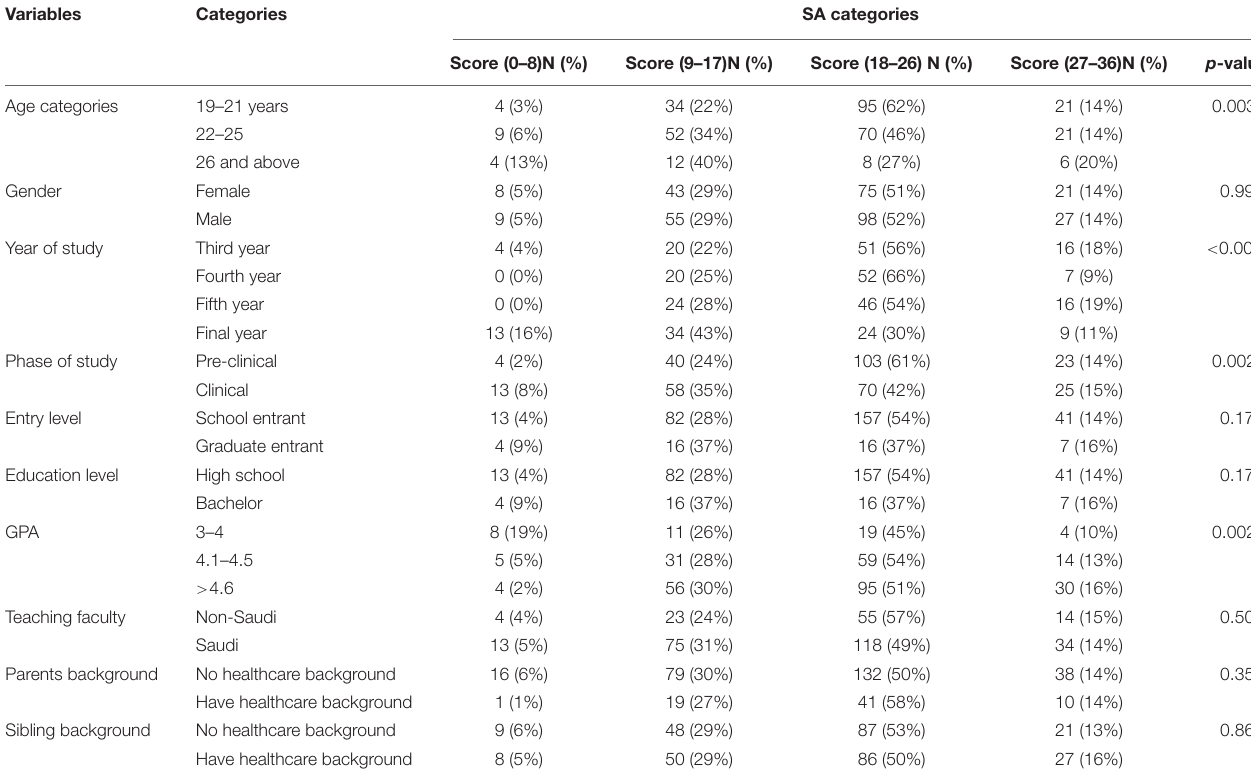
TABLE 3 | Association of the profile of participants with SA of the institution ( n =